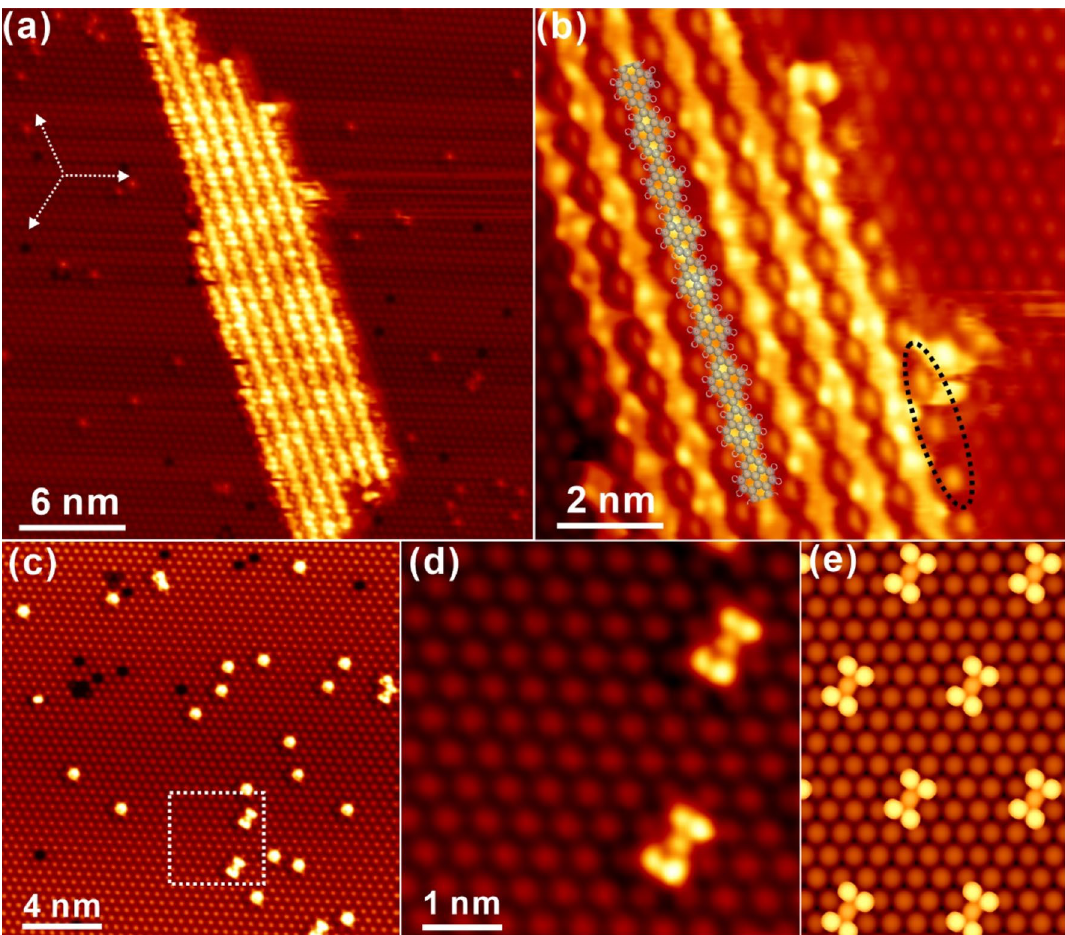
Figure 3. (a) Overview STM image taken after the deposition of Br 2 Py on the hot Bi–Ag(111) substrate kept at 530 K. (b) Zoom-in STM image of the polymer chains in panel (a) . (c) Overview STM image recorded on the bare Bi–Ag(111) substrate after dehalogenation and (d) zoom-in view of the white framed region in panel (c) . U bias = − 1.8 V, I t = 0.3 nA. (e) DFT simulation of Br clusters on Bi(111)–Ag at the bias of − 1.8